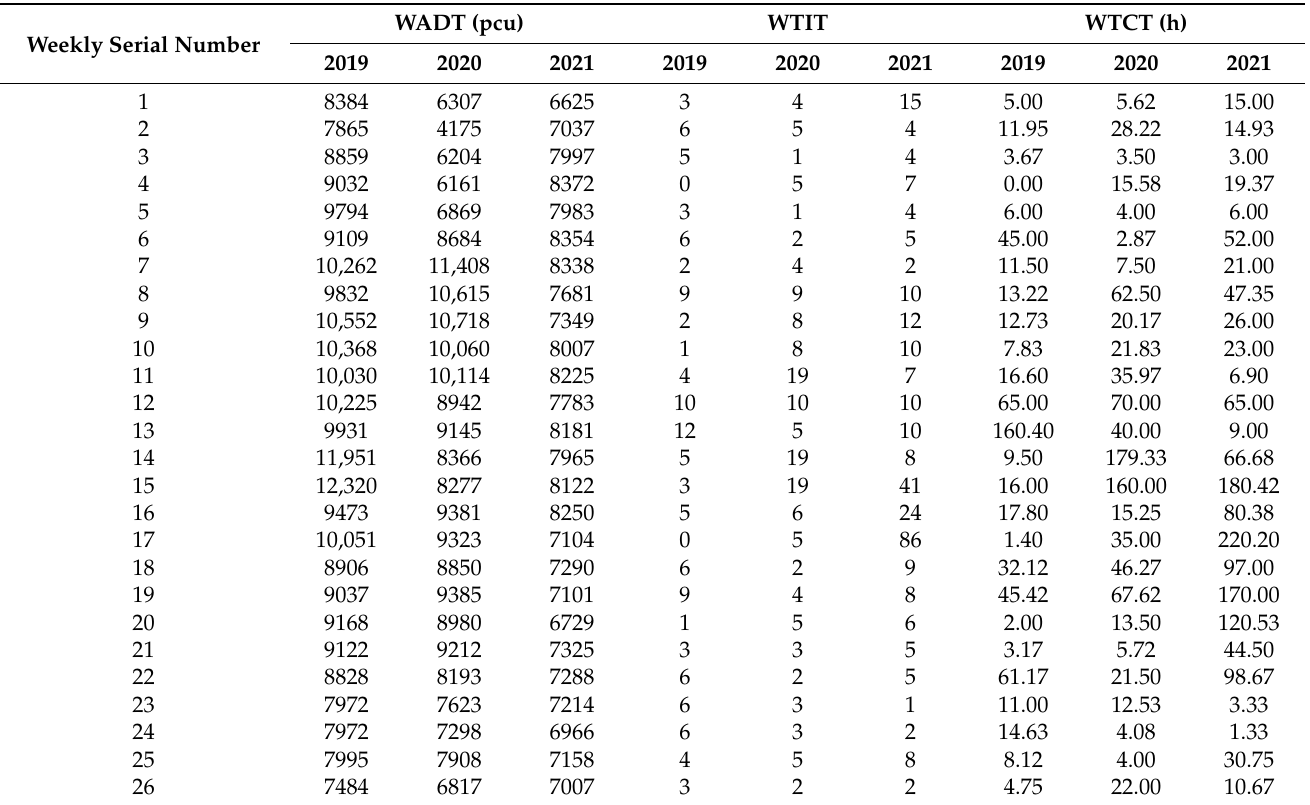
Table 1. Time series analysis dataset of the NPTHN service level assessment